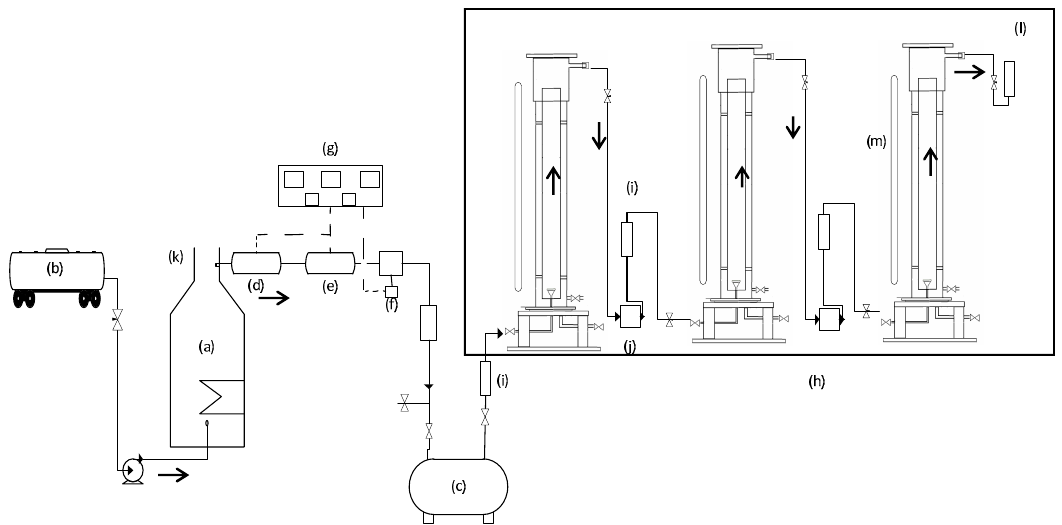
Figure 1. Process of CO 2 capture from gas emissions. ( a ) Commercial steam boiler. ( b ) Diesel tank. ( c ) Combustion gas storage tank. ( d ) Soot filter. ( e ) Catalytic converter. ( f ) Gas compressor. ( g ) Control panel. ( h ) Biorreactors. ( i ) Rotameters. ( j ) small gas pump. ( k ) boiler chimney. ( l ) Isotermal box and ( m ) Lamps.